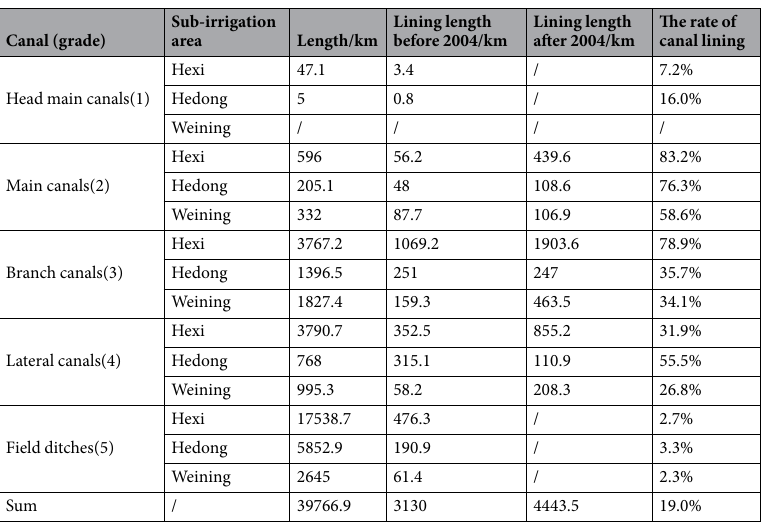
Table 1. Current state of the canal system in the NIA. In 2004, the local governments of Ningxia implemented the water rights transfer through canal